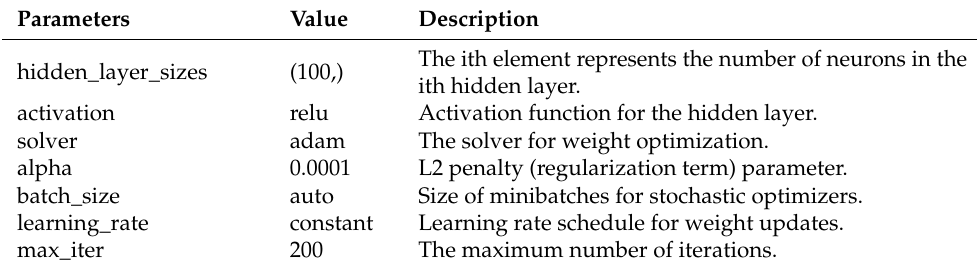
Table 12. ANN parameters from scikit-learn